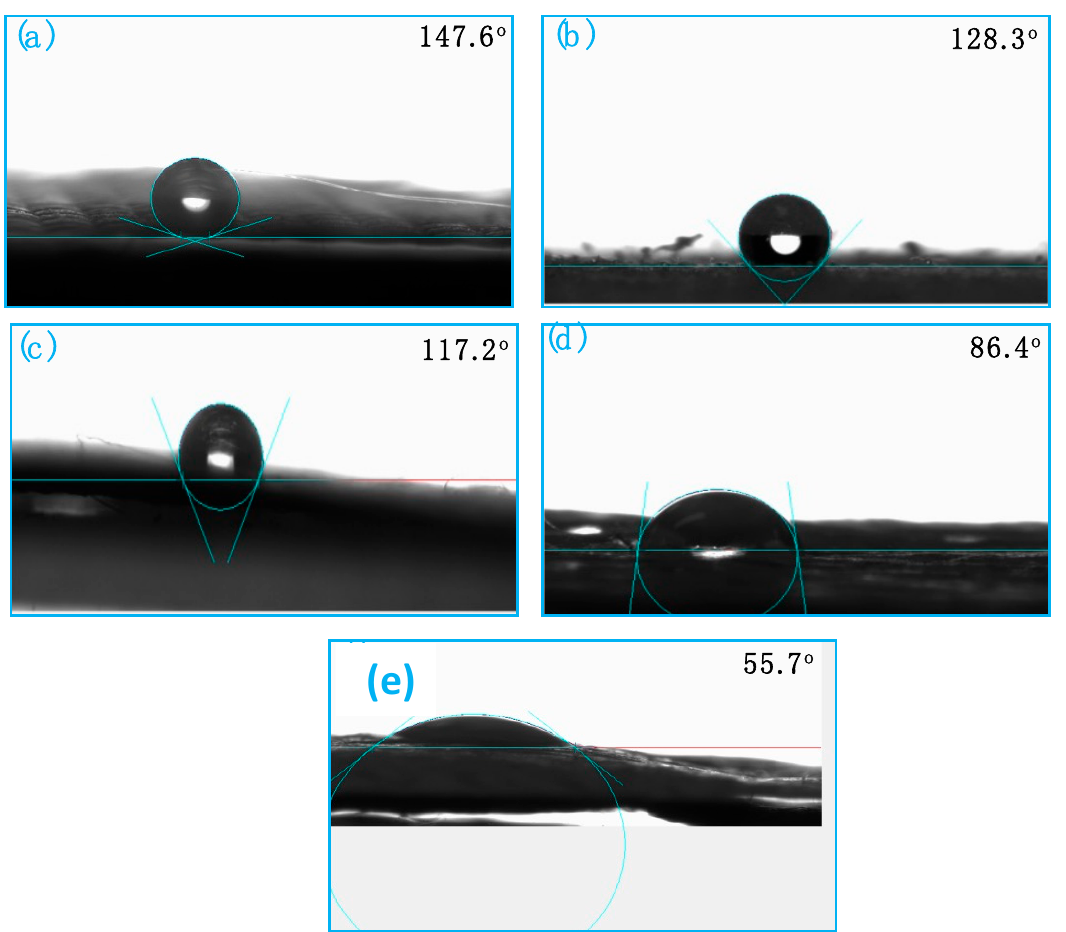
Figure 6. Contact angle of ( a ) PU nanofibers, ( b ) AgNPs-0@NFs, ( c ) AgNPs-1@NFs, ( d ) AgNP©@NFs and ( e ) AgNPs-3@NFs.